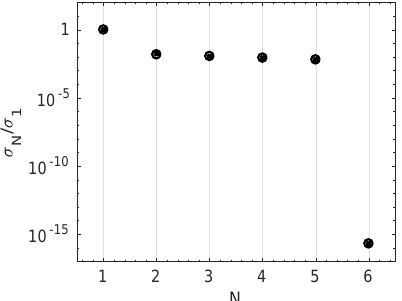
Figure 6. Singular values calculated in the data sets obtained in the left and right sides of the wind turbines, represented by crosses and circles,